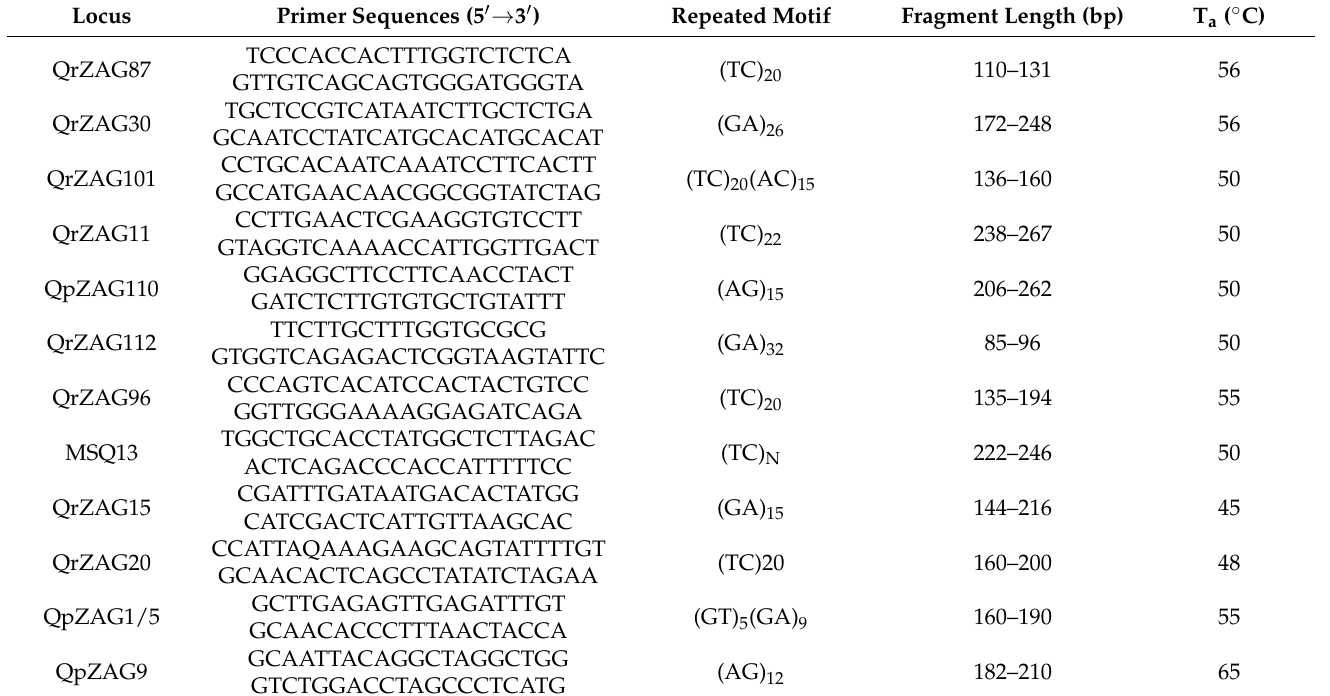
Table 2. Analyzed loci of pedunculate oak populations, sequences of microsatellite primers, repeated motifs, fragment length (bp), and specific primer annealing temperatures (Ta).